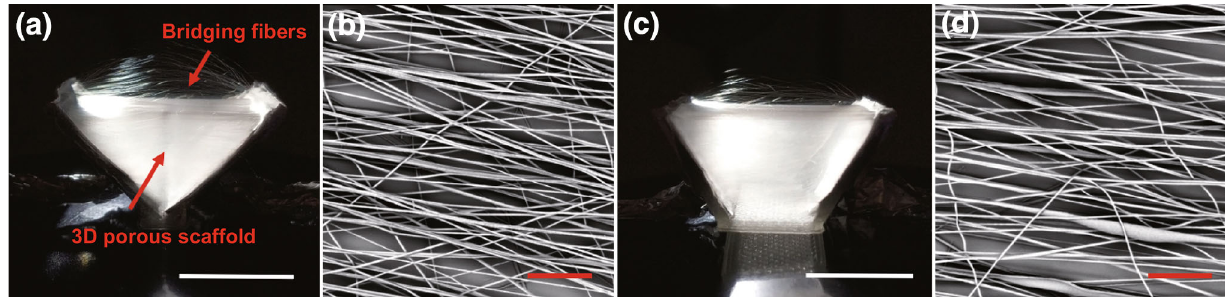
Fig. 3 3D nanofiber scaffolds formed in the a 45 (cid:3) -collector and c 60 (cid:3) -collector. SEM pictures of the nanofibers at the b top of the 45 (cid:3) -collector and d 60 (cid:3) -collector. White scale bar = 10 mm and red scale bar = 10 l m. (Color figure online)